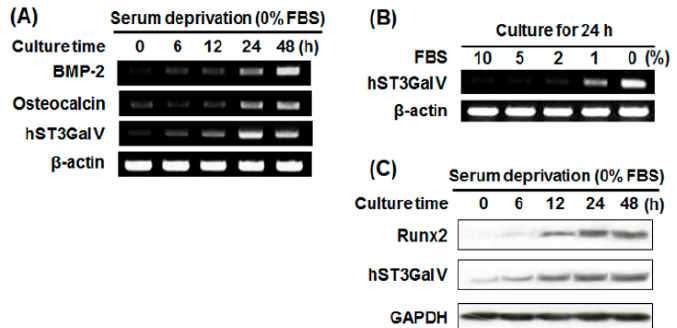
Figure 3. Effect of SD on the expression levels of osteoblastic markers and hST3Gal V. Total RNA from MG-63 cells was isolated after incubation in serum-free medium for the indicated time periods ( A ) or after culture for 24 h in medium containing various concentration of FBS ( B ), and mRNA transcripts of osteoblastic markers and hST3Gal V were detected by reverse transcription-polymerase chain reaction (RT-PCR). As an internal control, parallel reactions were performed to measure the levels of the housekeeping gene β -actin; ( C ) Equal amounts of cell lysates (20 μ g) were separated on sodium dodecyl sulfate (SDS)-polyacrylamide gels and transferred to a polyvinylidene fluoride (PVDF) membrane. The membrane was probed with specific antibodies against Runx2 and hST3Gal V. GAPDH was used as an internal control.